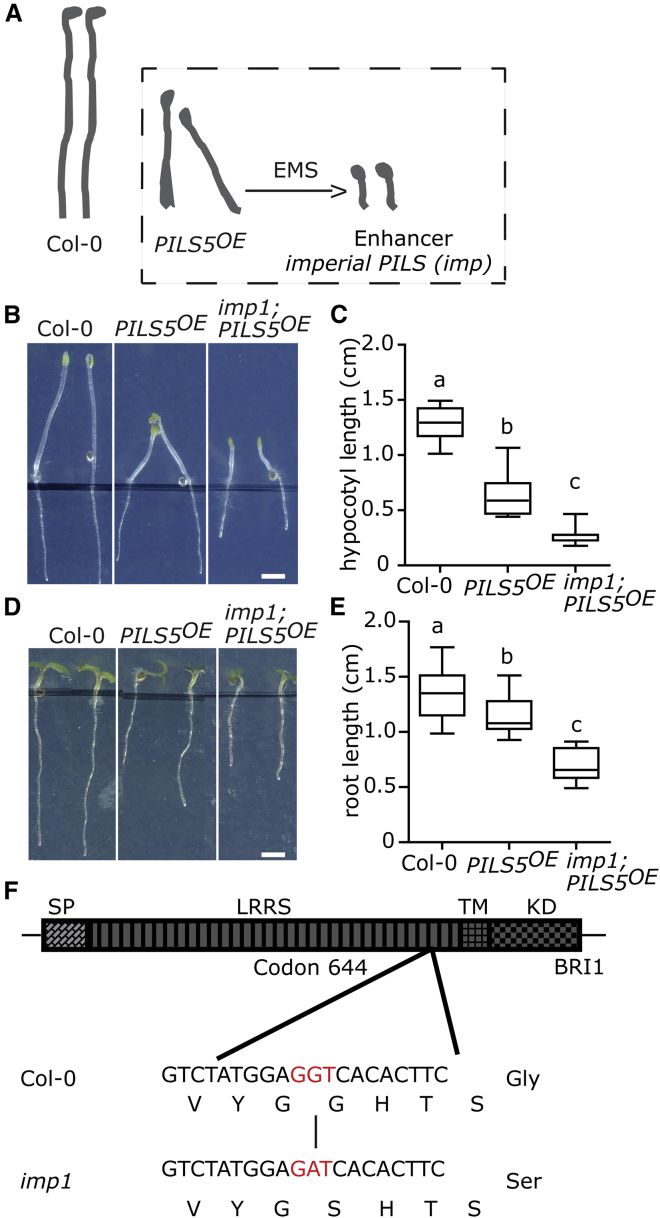
imp1 Mutation Enhances PILS5 Overexpression Phenotypes(A) Schematic diagram depicts the “EMS enhancer screen” for identification of genetic modulators of PILS5-related traits.(B–E) Images (B and D) and quantifications (C and E) of 4-day-old dark-grown (B and C) and 6-day-old light-grown (D and E) seedlings of wild-type (Col-0/WT), PILS5OE, and imp1 mutant grown on ½ MS. Scale bar, 3 mm (B and D). (n > 25). Letters indicate values with statistically significant differences (p < 0.01, one-way ANOVA (C and E)).(F) Sketch of imp1 mutation in the BRI1 locus. The diagram shows the full-length BRI1 protein with a defined signal peptide (SP), leucine-rich repeat (LRR), transmembrane (TM), and kinase (KD) domain. The change of G to A in imp1 results in the conversion of glycine (G) to serine (S) at amino-acid residue 644 in the LRR domain of BRI1.